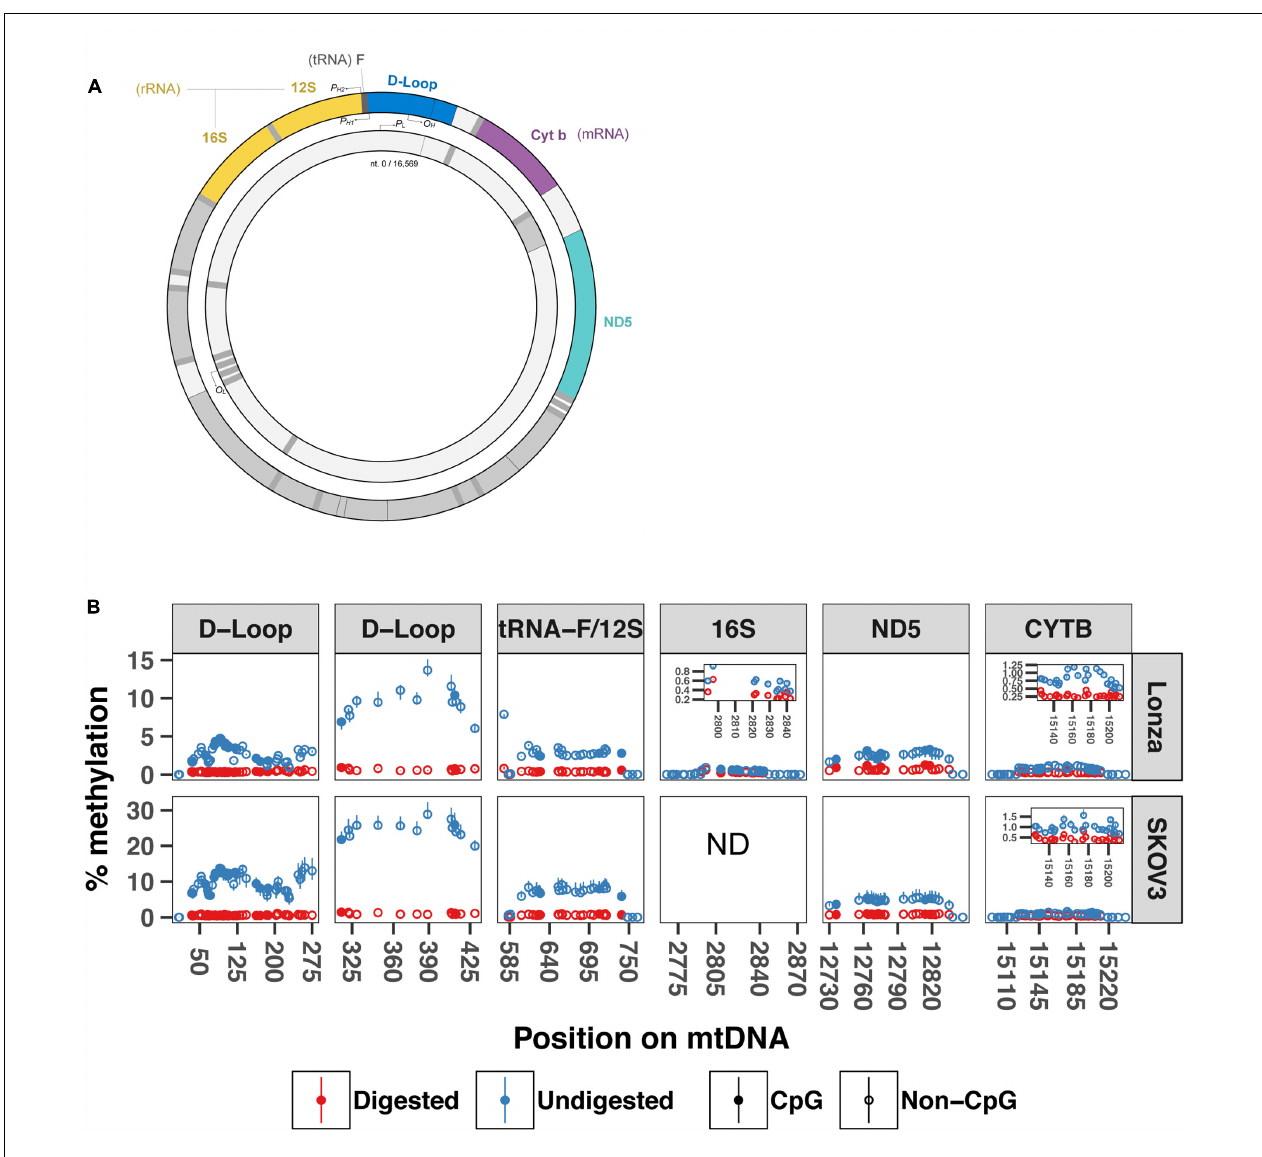
FIGURE 3 | BamHI digestion prior to bisulfite sequencing decreases cytosine unconvertion rate. Targeted bisulfite sequencing was used to compare undigested and digested DNA methylation levels at five different regions of the mtDNA from human muscle cells and SKOV3 cells ( N = 3). (A) Drawing displays the mtDNA regions investigated by targeted bisulfite sequencing. (B) Percentage methylation for undigested and digested mtDNA. Full circle represents cytosines in CpG context whereas open circle is cytosines in non-CpG context. Results are presented with a min-max interval and a sign test was used to test for significant methylation differences. D-loop (6–298) P = 2.02E-41 (Lonza) and P = 1.40E-24 (SKOV3); D-loop (279–458): P = 5.00E-12 (Lonza) and P = 8.20E-08 (SKOV3); tRNA-F+12S: P = 9.22E-15 (Lonza) and P = 1.29E-9 (SKOV3); 16S: P = 6.50E-05; ND5: P = 1.70E-05 (Lonza) and P = 9.97E-13 (SKOV3); CYTB: P = 2.96E-09 (Lonza), and P = 6.68E-13 (SKOV3). D-loop (6–298) includes origin of replication and tRNA-F+12S includes heavy strand promoter 2. P H1 : heavy-strand promoter 1; P H2 : Heavy-strand promote 2; P L : Light-strand promoter; OH: Origin of replication from heavy-strand; O L : Origin of replication from light-strand. ND: not